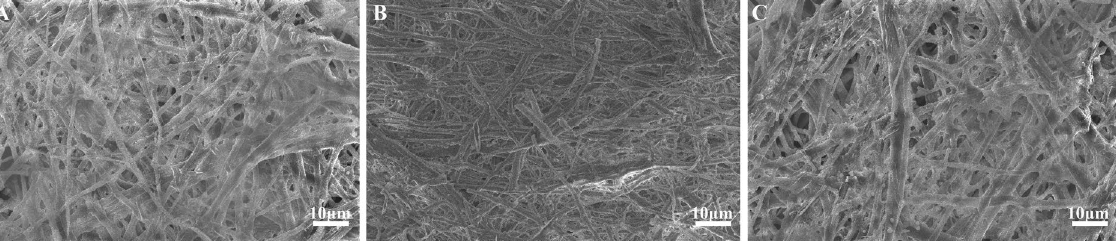
Figure 1. Characterization of acid- and alkali-treated EM. SEM images of EM treated for 72 hours with aqueous solutions of different pH values: ( A ) pH = 3; ( B ) DDH 2 O; and ( C ) pH = 11 (n =